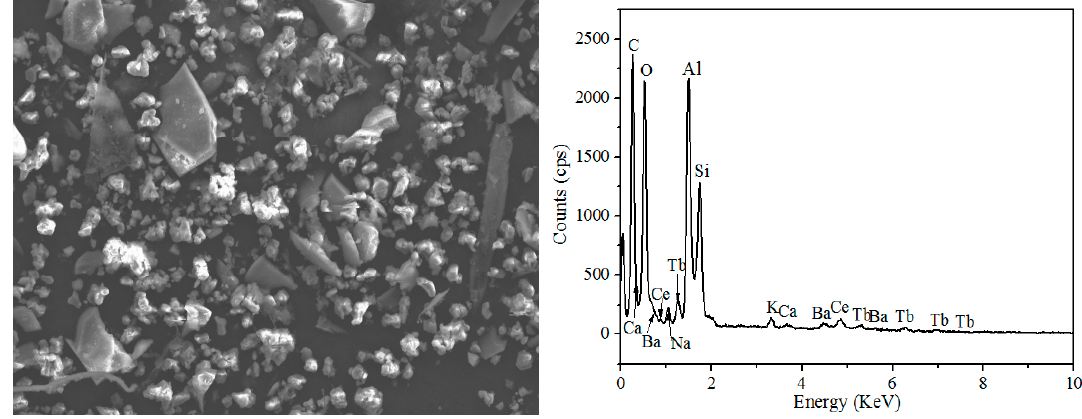
Figure 7. SEM-EDS analysis of the leach residue.